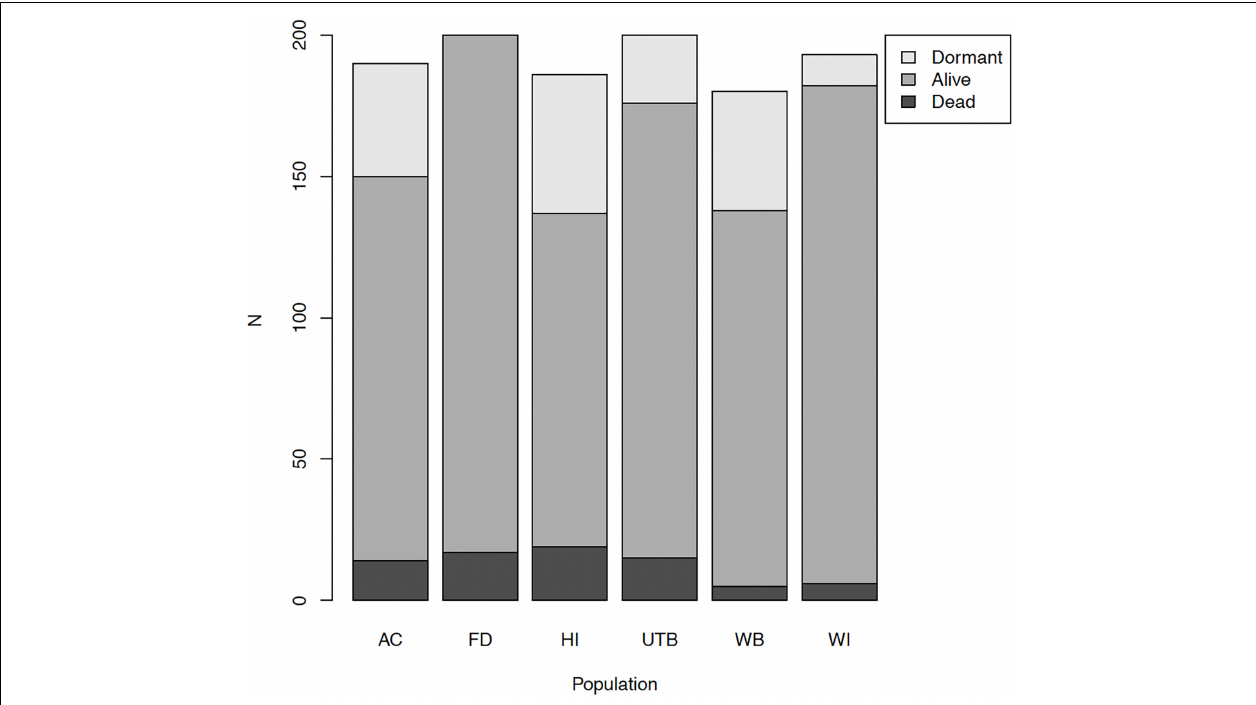
FIGURE 2 | Absolute numbers of plants in each growth state at harvest by population of origin. Dormant plants (light gray) showed no signs of desiccation or growth. Seedlings from the HI population had the lowest survival overall, while WI seedlings had the highest survival. Plants alive at harvest are medium gray, plants that had died by harvest are dark